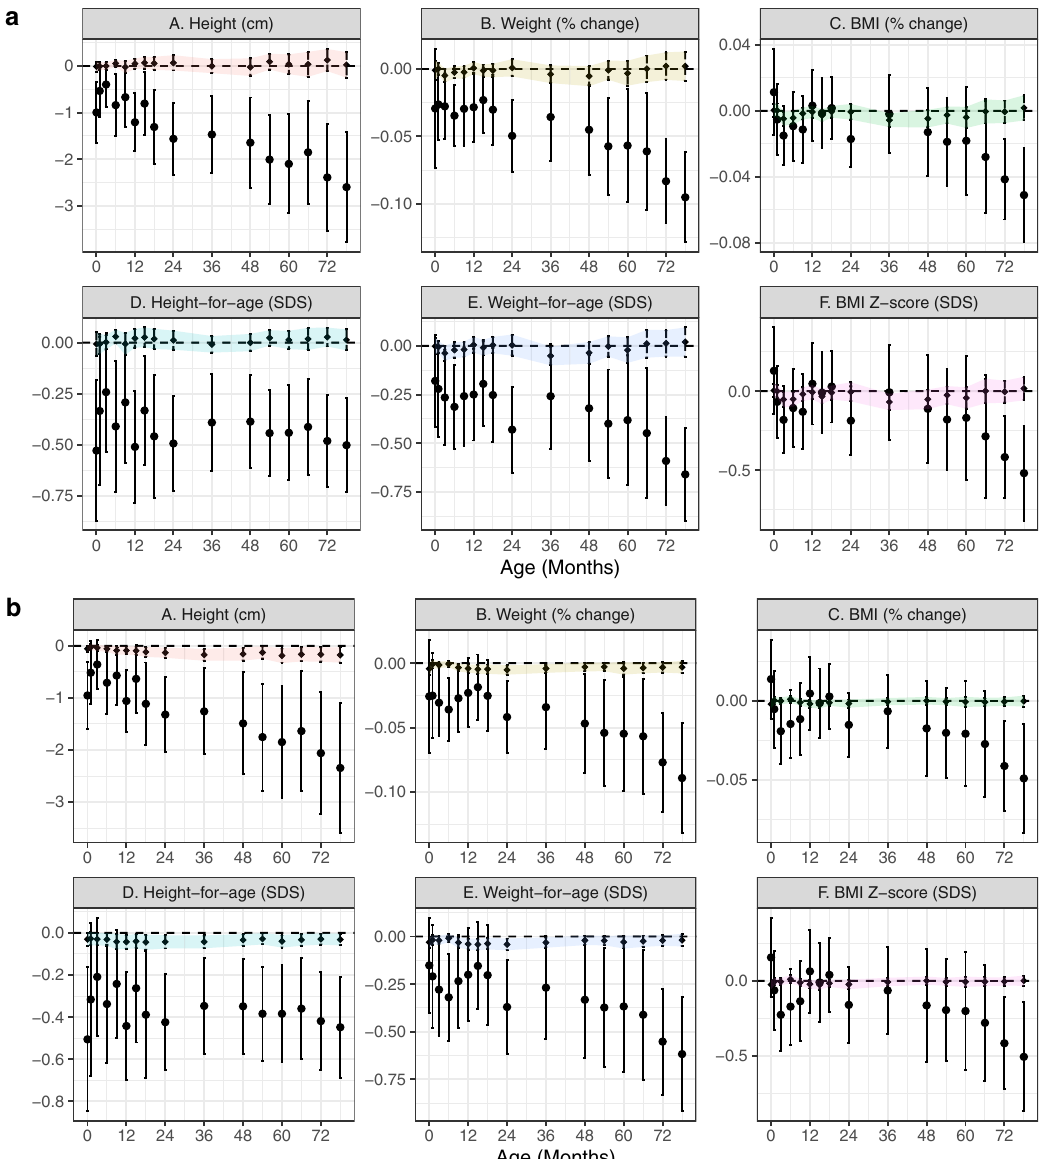
Fig. 5 Monte Carlo-simulated effects of ART mediated through fetal cord tissue methylation, overall sample. The solid lines show the estimates and Wald-type 95% con fi dence intervals for the hypothetical average direct treatment effect of assigning all subjects to ART (versus spontaneous conception) while holding methylation for ( a ) cg03904042 ( NECAB3 ) or ( b ) cg27146050 ( HIF3A ) at the untreated (SC) level. Point estimates and standard errors were estimated by parametric g-computation in 100 bootstrapped datasets. The dashed and shaded regions show the speci fi c indirect effect of fi xing the methylation level to that caused by ART itself (compared to the level that would have been observed without treatment) among ART-conceived children. Sample sizes across visits are identical to Fig. 1. cm centimeters, SDS standard deviation score; colors used to distinguish outcome measures. Shaded regions connect con fi dence intervals to aid in visualizing trends and provide no additional information regarding estimates between